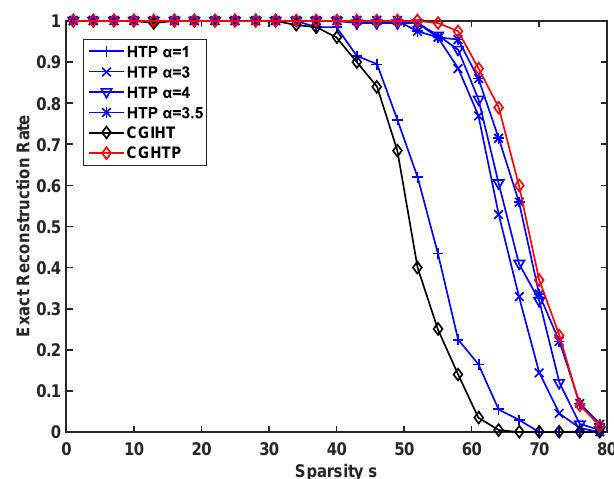
Figure 8. Exact reconstruction rate vs. sparsity level for a Gaussian signal.